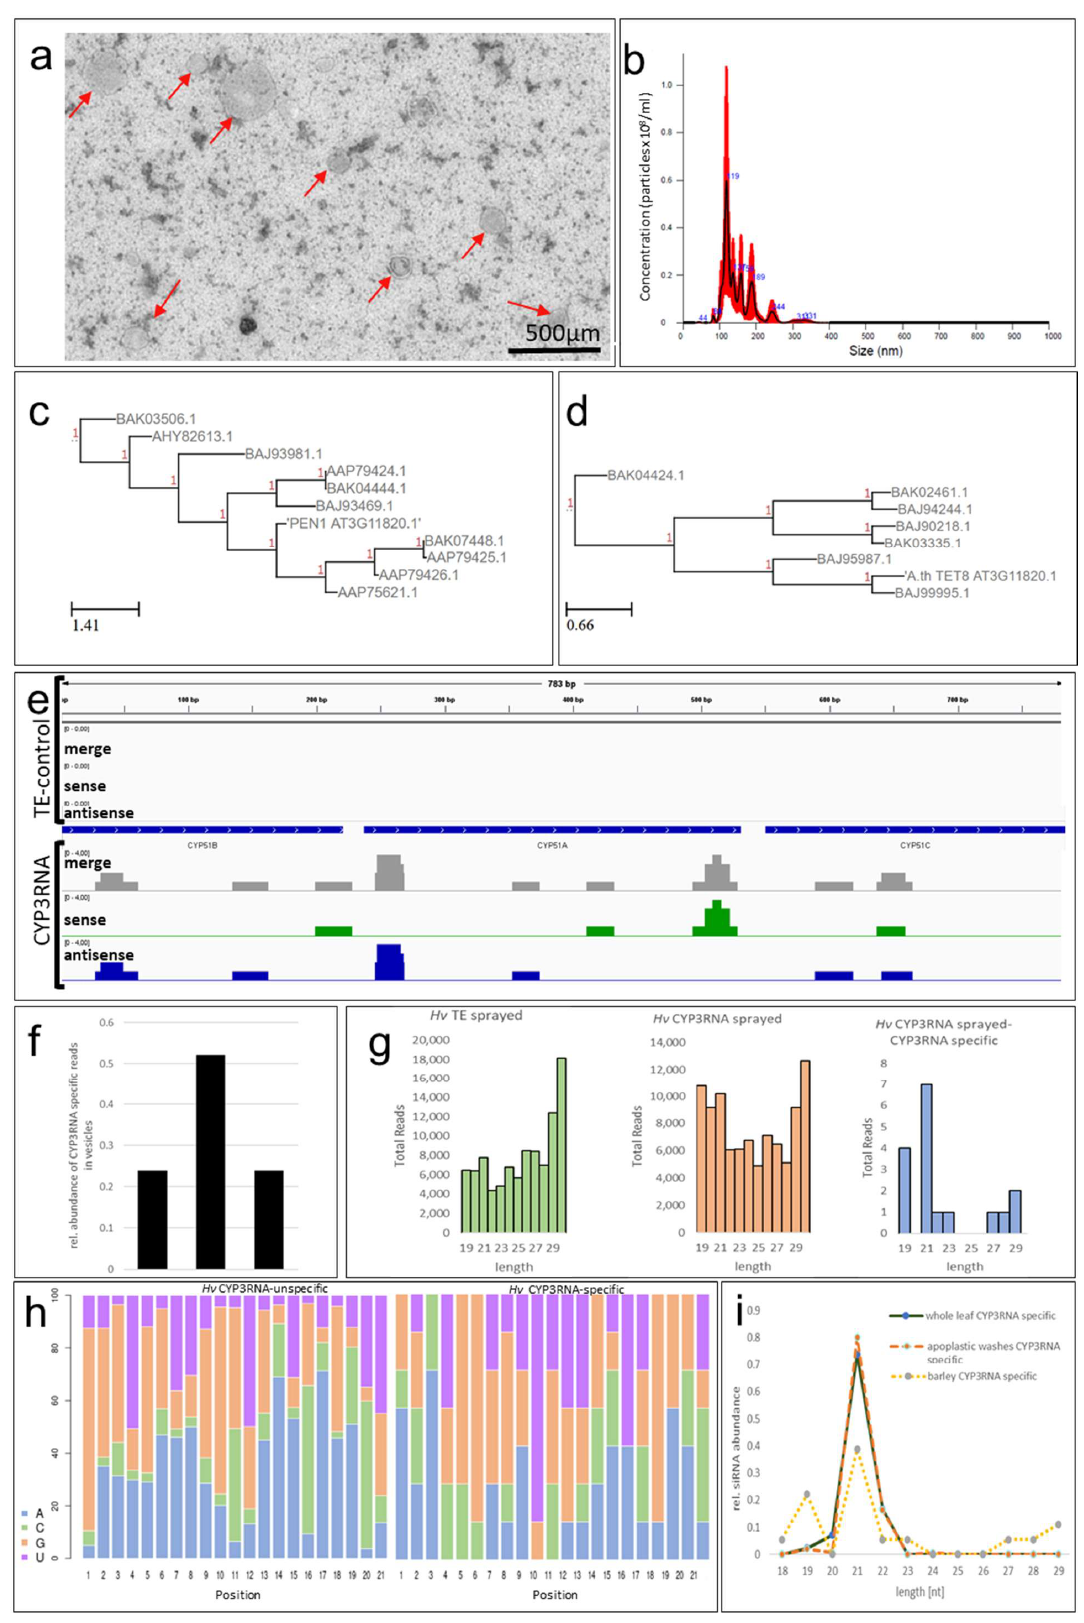
Figure 1. ( a ) Barley EVs were negatively stained onto copper formvar meshes using 2% uranyl acetate. ( b ) Next, 5 µ L of purified EVs was diluted up to a volume of 500 µ L. The vesicle suspension was loaded onto a Nanosight NS300 (Malvern